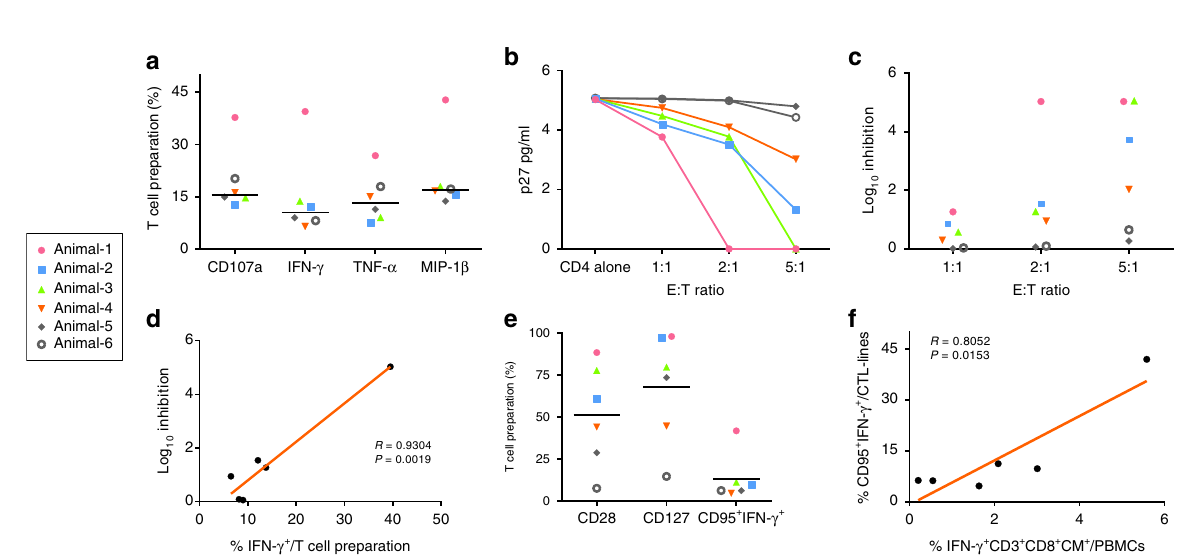
Fig. 4 Phenotypic and functional characterization of CTL-lines. a In vitro speci fi c antigen recognition of CTL-lines. Data is shown as Grand median for each group. Each symbol represented one animal ( n = 6). b P27 titers in the culture supernatants of PHA-activated CD4 + T-cells infected in vitro with replicative SHIV-SF162P3, in the absence (CD4 alone) or presence of autologous CTL Lines (1:1, 2:1 and 5:1 of ET ratio). Each symbol represented one animal ( n = 6). c The capacity of CTL-lines to suppress SHIV replication in autologous CD4 + T-cells. The Log of p27 decreased when CD4 + T-cells were cocultured with CTL-lines. Each symbol represented one animal ( n = 6). d Correlation between cytotoxic capacity (% inhibition) and frequencies of Env- speci fi c IFN- γ producing (Spearman ’ s correlation coef fi cient (R) and P values are indicated. Note that y-axis is log 10 scales, n = 6). e Memory phenotypic characterization of CTL-lines. Data is shown as Grand median for each group. Each symbol represented one animal ( n = 6). f Relationship between PBMCs Env-speci fi c, IFN- γ + CD3 + CD8 + central memory T cells post-infusion and Env-speci fi c memory response of CTL-lines (Spearman ’ s correlation coef fi cient (R) and P values are indicated, n =